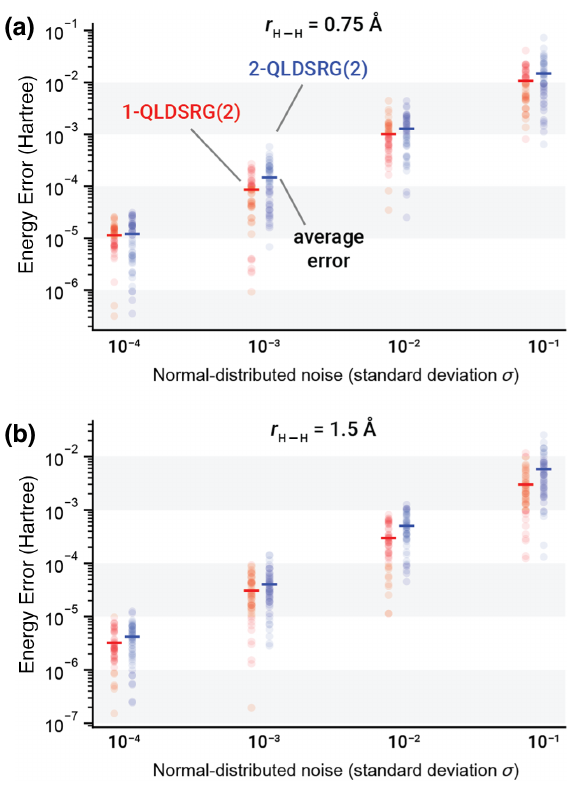
FIG. 2. The energy error for the H 2 molecule (in m E h ) com- puted with the QLDSRG(2) with various amounts of stochastic noise ( σ ) added to the RDMs. For a given value of σ , the semiopaque circles aligned vertically show the distribution of errors from 50 computations, while the horizontal bars represent the average error. All computations use a cc-pVTZ basis [85] . The energy errors are and the flow parameter value s = 0.5 E − 2 h computed with respect to noiseless values. The data are obtained = 0 in the reconstruction of the approximate three- imposing γ 3 body cumulant.